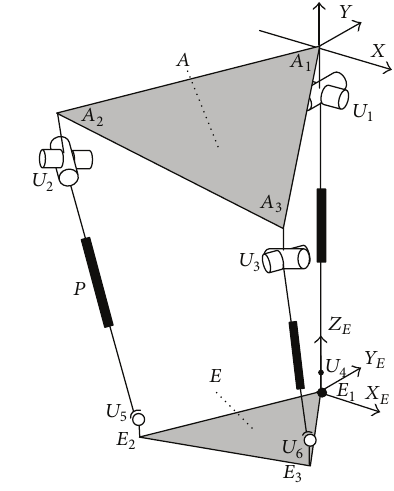
Figure 2: 2-UPS+UP PLM.